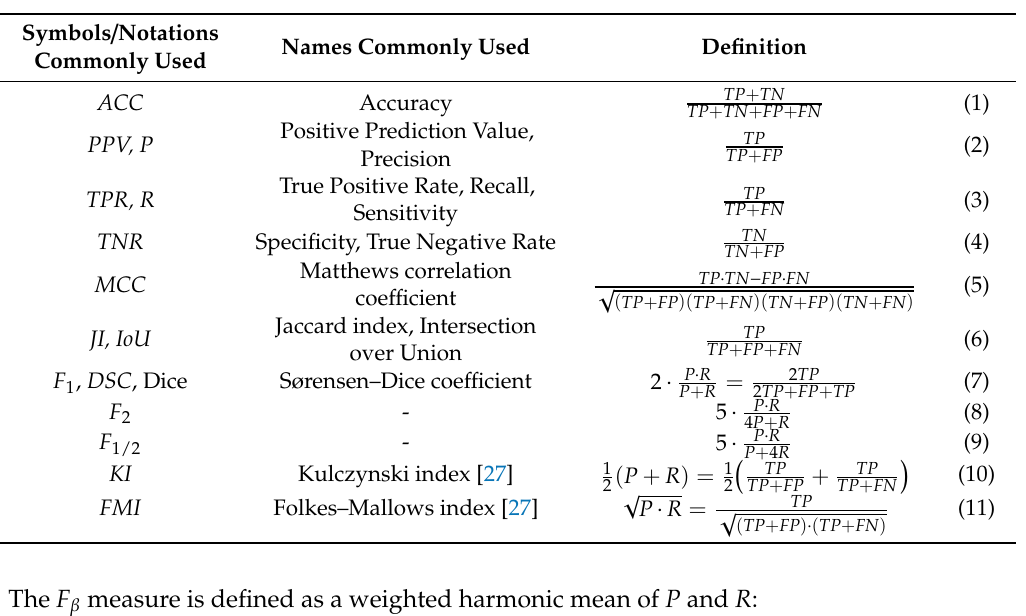
Table 4. List of external